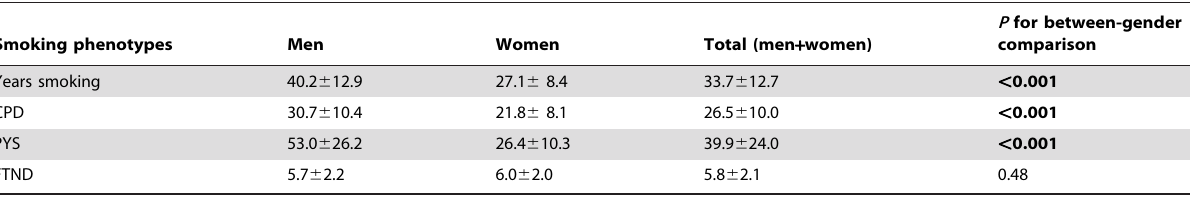
Table 1. Main characteristics of the smokers’ group.